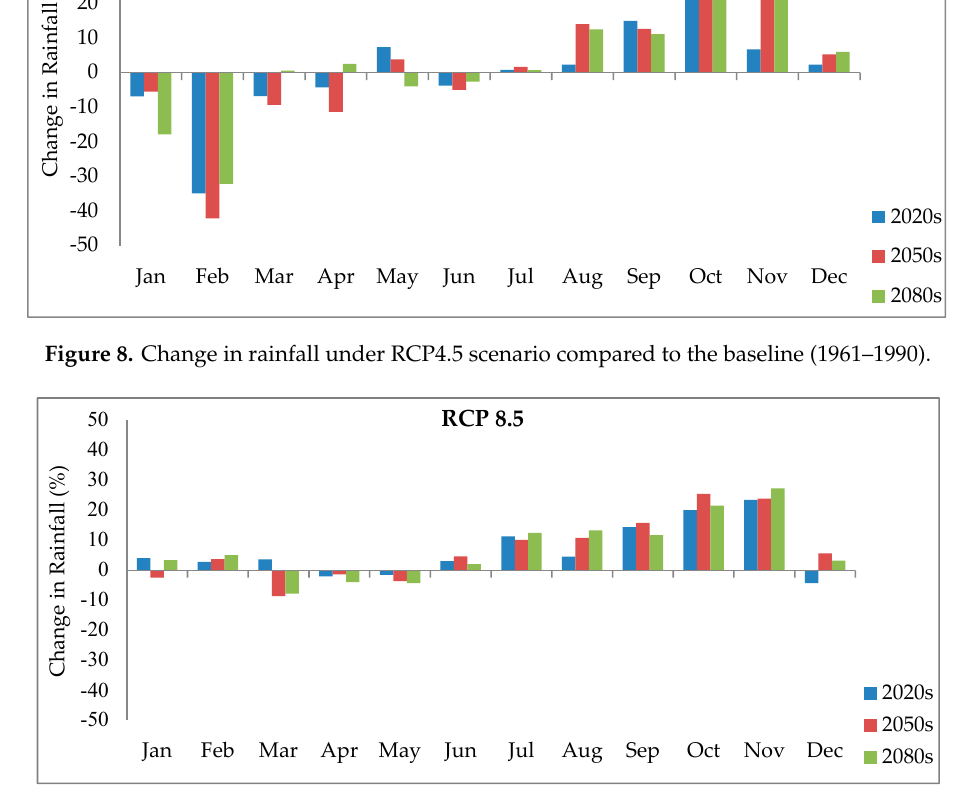
Figure 9. Change in rainfall under RCP8.5 scenarios compared to the baseline (1961–1990).